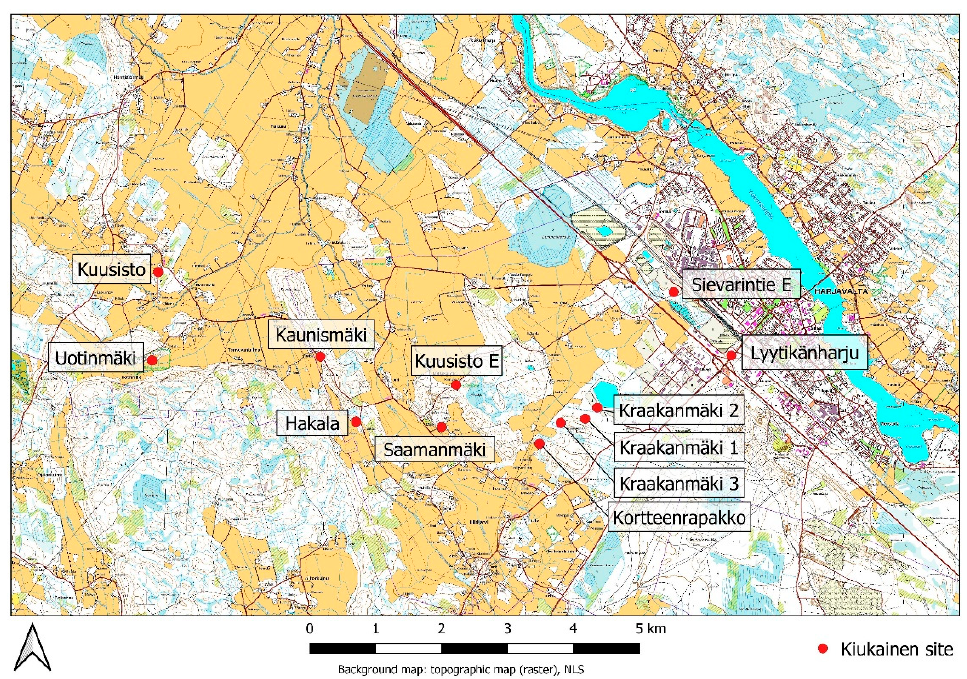
Figure 7. The locations of Kiukainen sites in the Harjavalta area. Grey areas in the background of the map are rocky areas, while the yellow areas are cultivated fields, and the light green or empty white areas in between are forests.